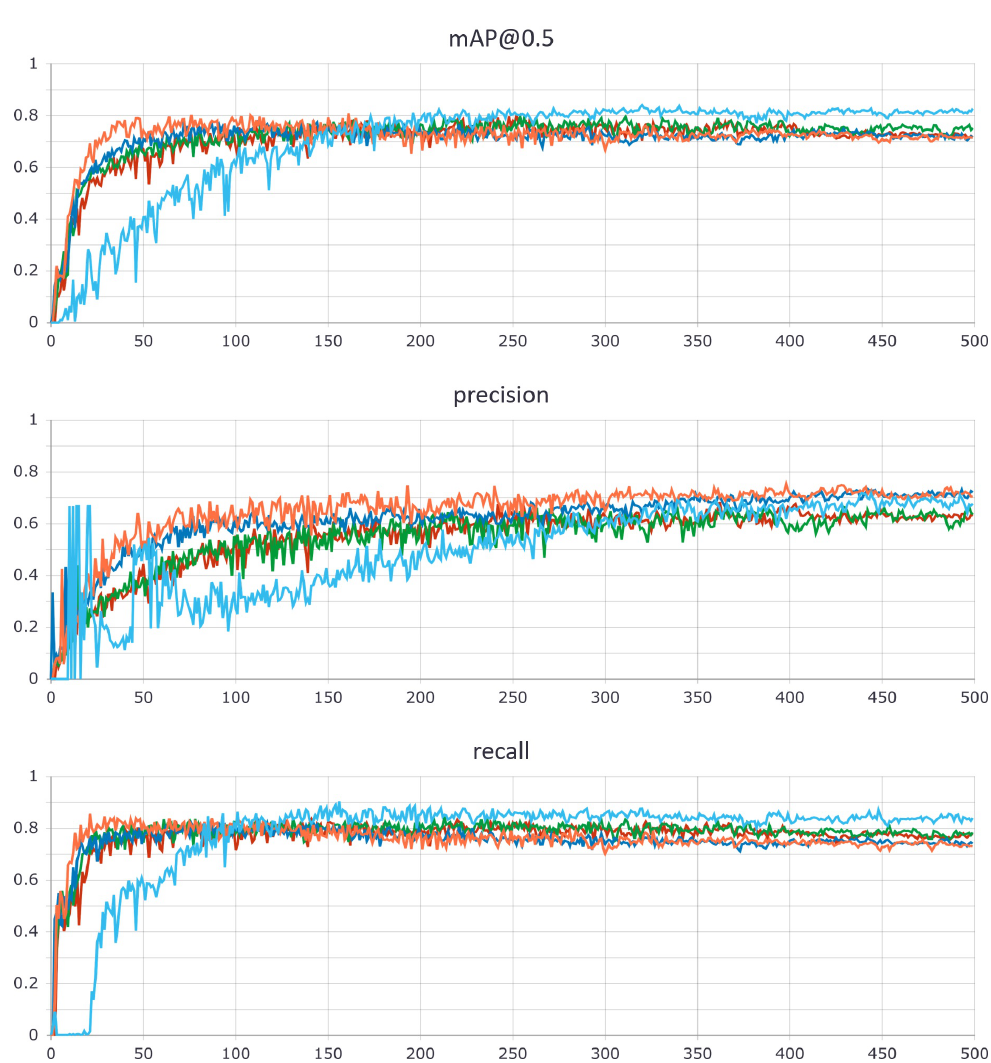
Figure 8. mAP@0.5, precision and recall curves: (Dark blue) 4da_512px_csp; (Green) 4da_512px_